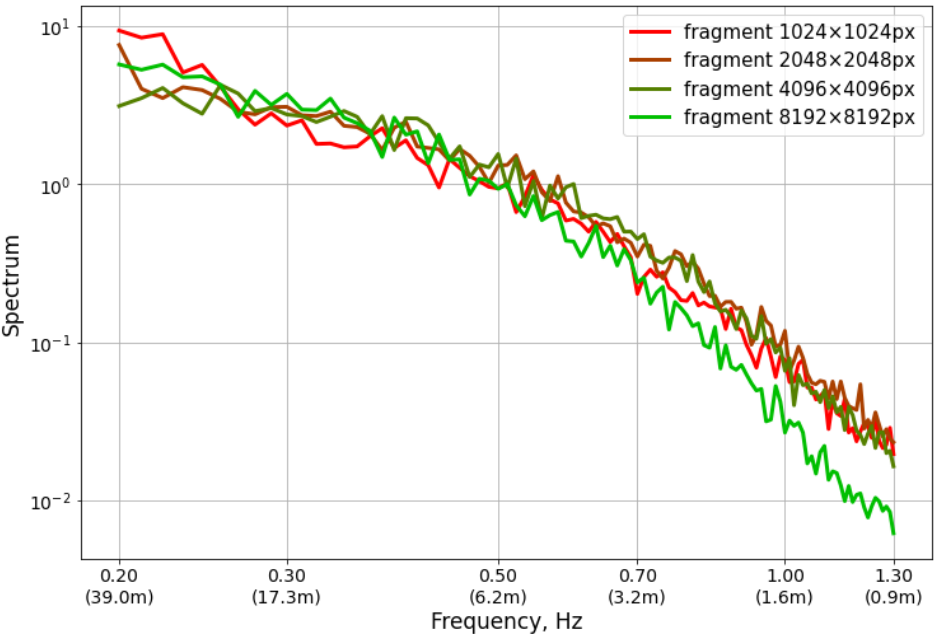
9 of 23 Figure 4. Panorama of the slope spectra. Slope spectra retrieved from 1024 × 1024 pixel (410 × 410 m) fragments are shown at the locations of the original satellite image fragments. For comparison with sea truth data, we transformed the obtained 2D spectra into frequency spectra using Equations (23) and (24). At the same time, in order to eliminate computational errors in the values of spectral density for the wave vector near the direc-